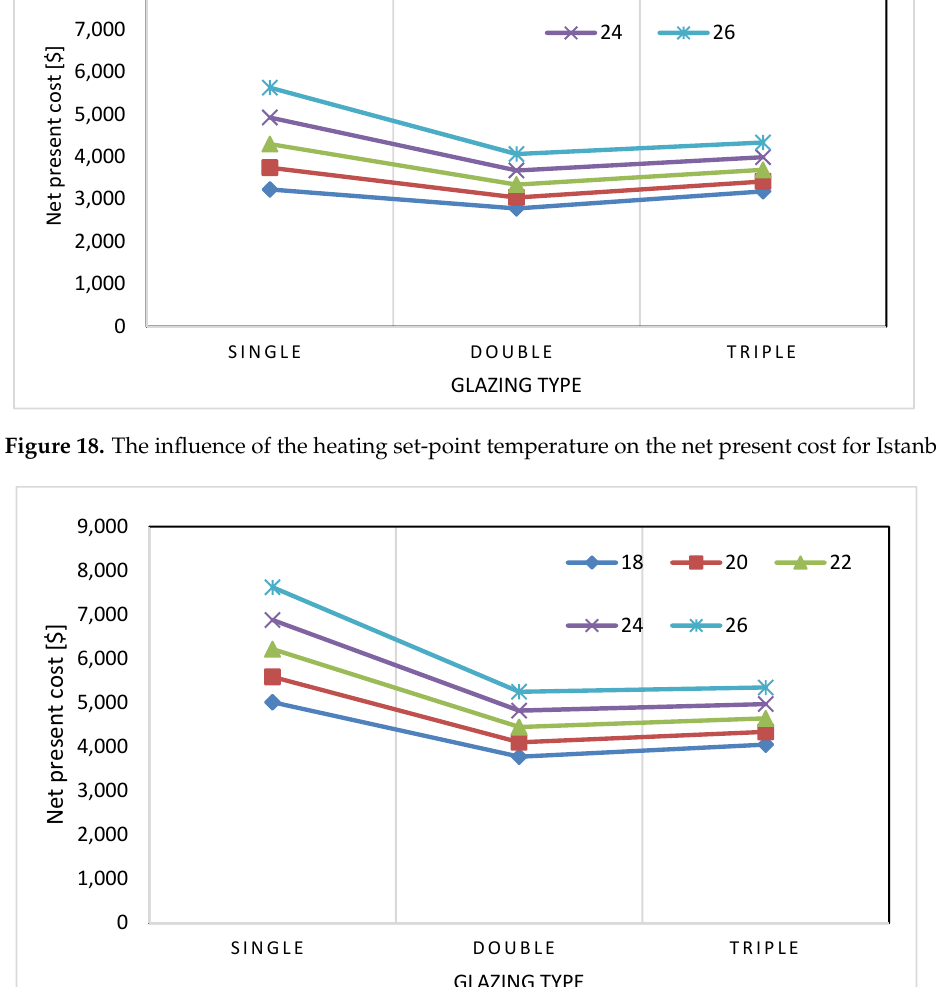
Figure 20. The influence of the fuel type on the net present cost for Istanbul .